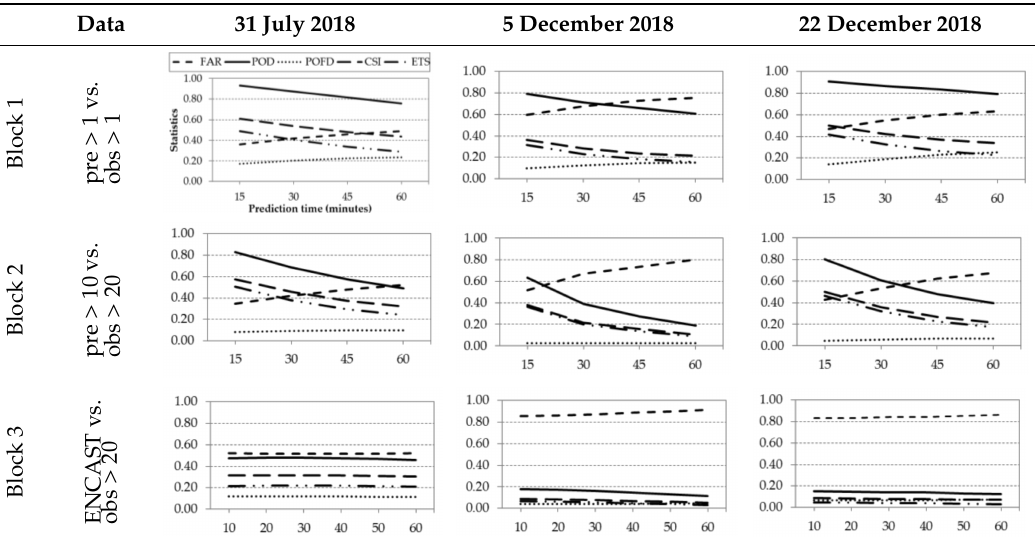
Table 3. Binary statistics of PredRNN ++ model (for 15, 30, 45 and 60-min prediction times) and ENCAST nowcasting model (for 10, 20, 30, 40, 50, 60-min prediction times) applied to selected cases: 31 July 2018, 05 December 2018 and 22 December 2018. The graphics and metrics are similar to those presented in Figure 5 and Table 2. The table is divided into three blocks according to the evaluated model and the thresholds: (Block 1) PredRNN ++ , pre > 1 dBZ and obs > 1 dBZ; (Block 2) PredRNN ++ , pre > 10 dBZ and obs > 20 dBZ; (Block 3) ENCAST, ENCAST > 1 mm / h and obs > 20